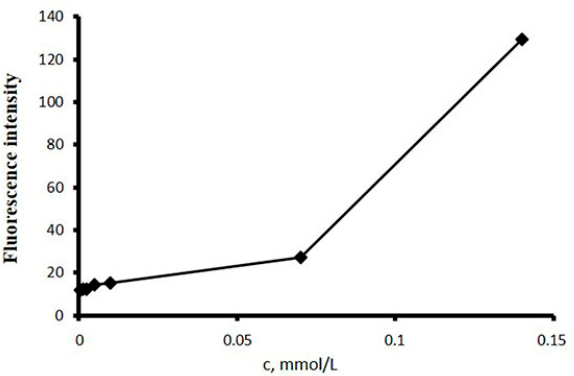
Figure 2. Fluorescence intensity of the p(VP-AA)-ODM solution with DPHT at 25 °C.